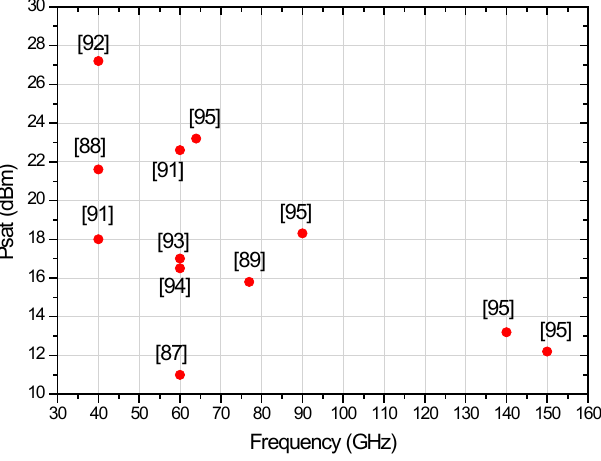
Figure 5. Saturation power of the recent published MMW CMOS PAs. Data taken from [87–95].